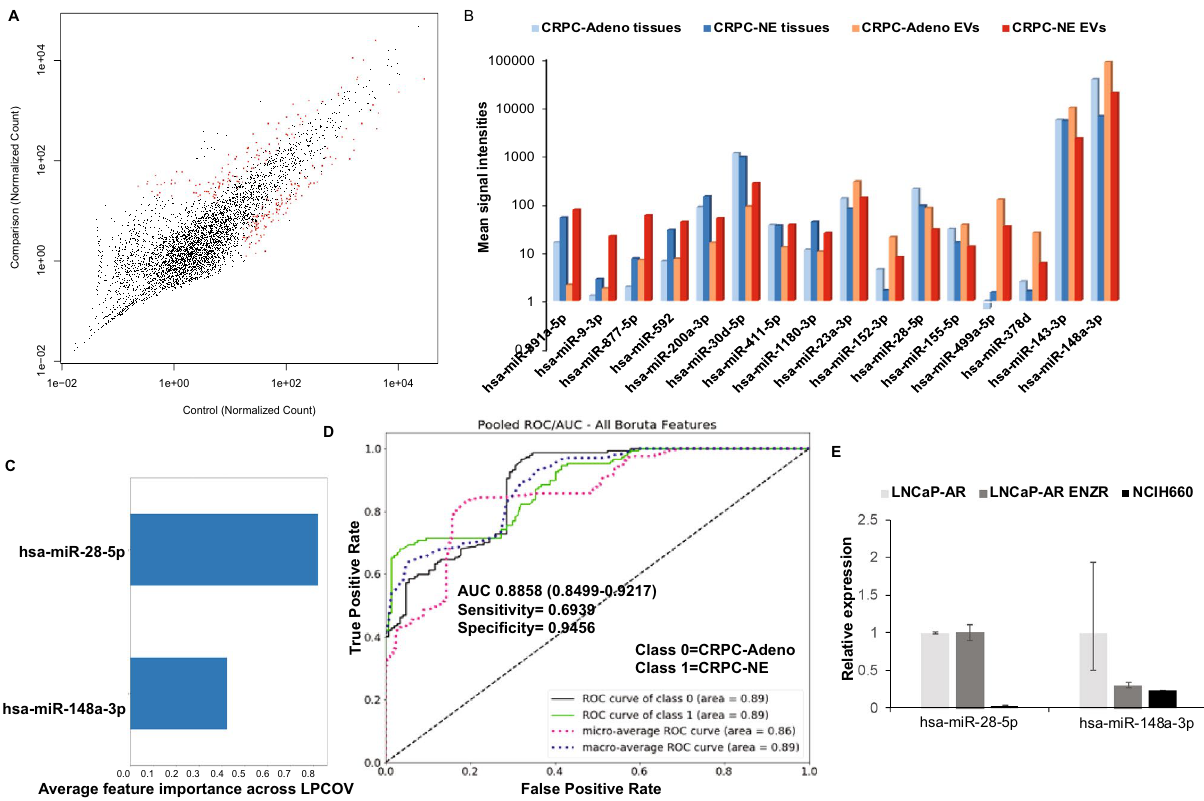
Figure 4. EV miRNA alterations in prostate cancer tissues undergoing NED. ( A ) Scatter plot showing EV-miRNA alterations in CRCP-Adeno vs CRPC-NE tissues profiled by small RNA NGS. ( B ) Plot comparing miRNA signal intensities of tissue and corresponding serum EV samples in CRPC-Adenocracinoma vs CRPC-NE cases. ( C ) Machine learning method as applied to EV-miRNA alterations that were also observed in corresponding prostate cancer tissues. ( D ) ROC curve analyses showing the ability of two-EV-miRNA classifier to distinguish between class 0 (CRPC-Adeno) and class 1 (CRPC-NE). ( E ) Validation of two-EV-miRNA classifier in NEPC cellular model NCI-H660 compared to parental LNCaP-AR and LNCaP-AR ENZ resistant cells by real time PCR based expression